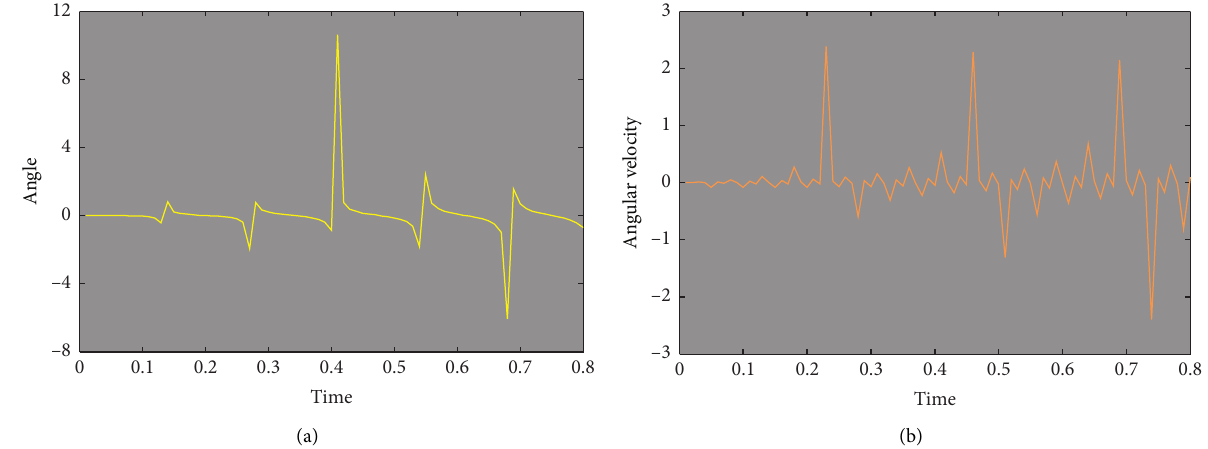
Figure 7: Measurement data of circular magnetic grid: (a) angle data; (b) angular velocity data.